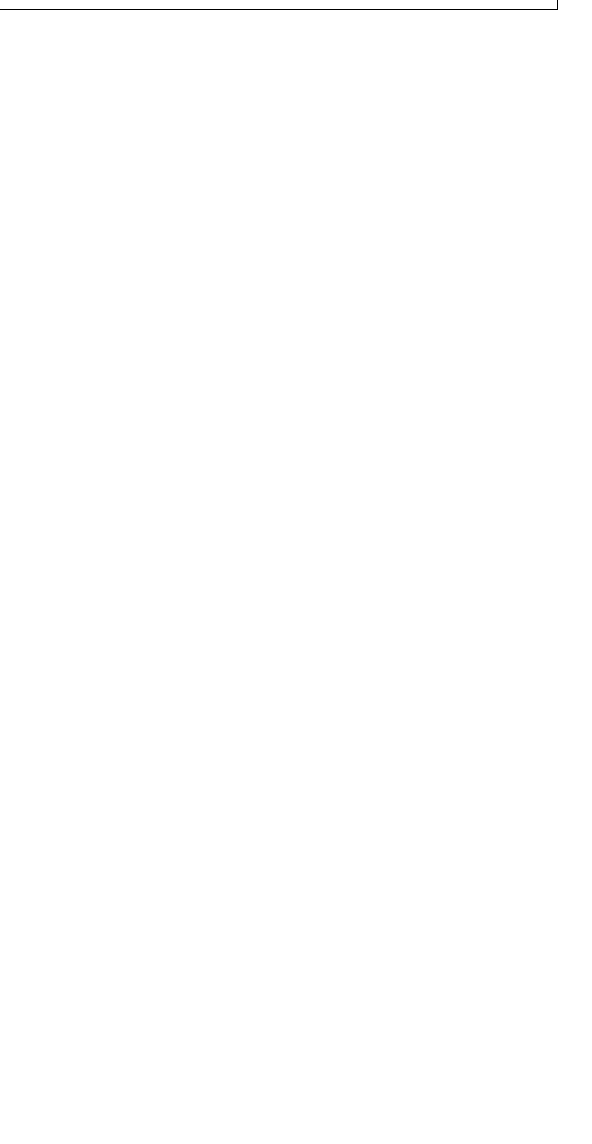
FIGUREA1 |Anti-CD4 treatment does not directly depleteT cells in the absence of antigen . DO11.10.Rag − / − mice were treated with two shots of 1mg anti-CD4 in alternate days. Spleen and LN were collected at day 7 and stained with theTCR-specific mAb (KJ1-26) and Foxp3. No significant difference was observed in the frequency or number ofT cells from mAb-treated